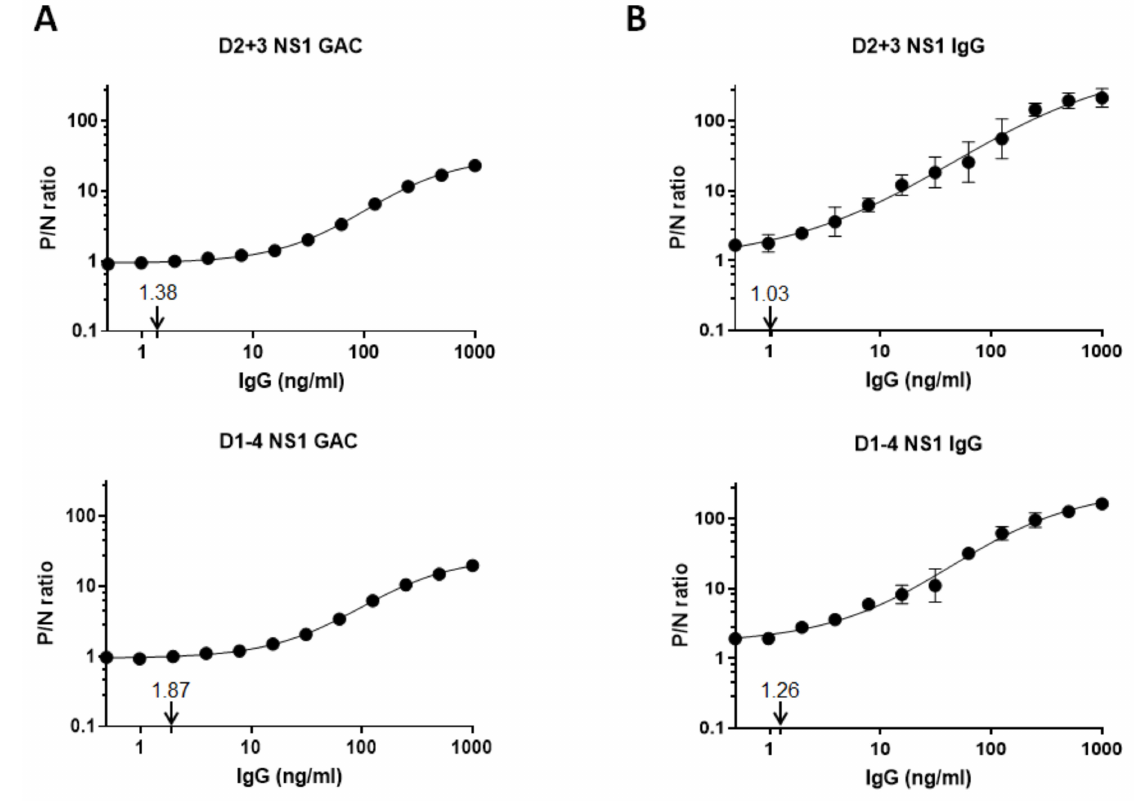
Figure 5. Limits of detection of NS1 GAC- and indirect NS1 IgG ELISAs. Purified pan-flavivirus anti-NS1 chimeric mhFL0221 monoclonal IgG and negative control IgG were twofold titrated at varying concentrations to compare the limits of detection of ( A ) NS1 GAC- ( B ) and indirect NS1 IgG ELISAs using a combination of DENV2 + 3 or DENV1–4 NS1 antigens. The P/N ratio is plotted against anti-NS1 IgG concentration (ng/mL). The limit of detection, indicated with an arrow, is the estimated minimum detectable IgG concentration, as determined by a four-parameter logistic log fit model of the standard curve data. Error bars indicate standard deviations of